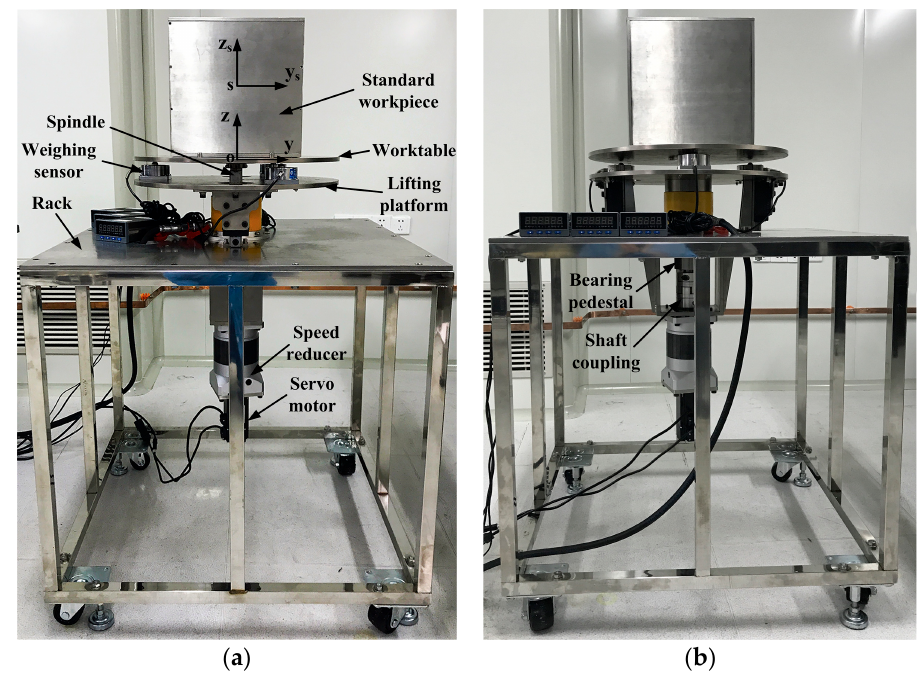
Figure 4. The position relationship between the standard workpiece and mass measurement system ( a ) front view; ( b ) side view.